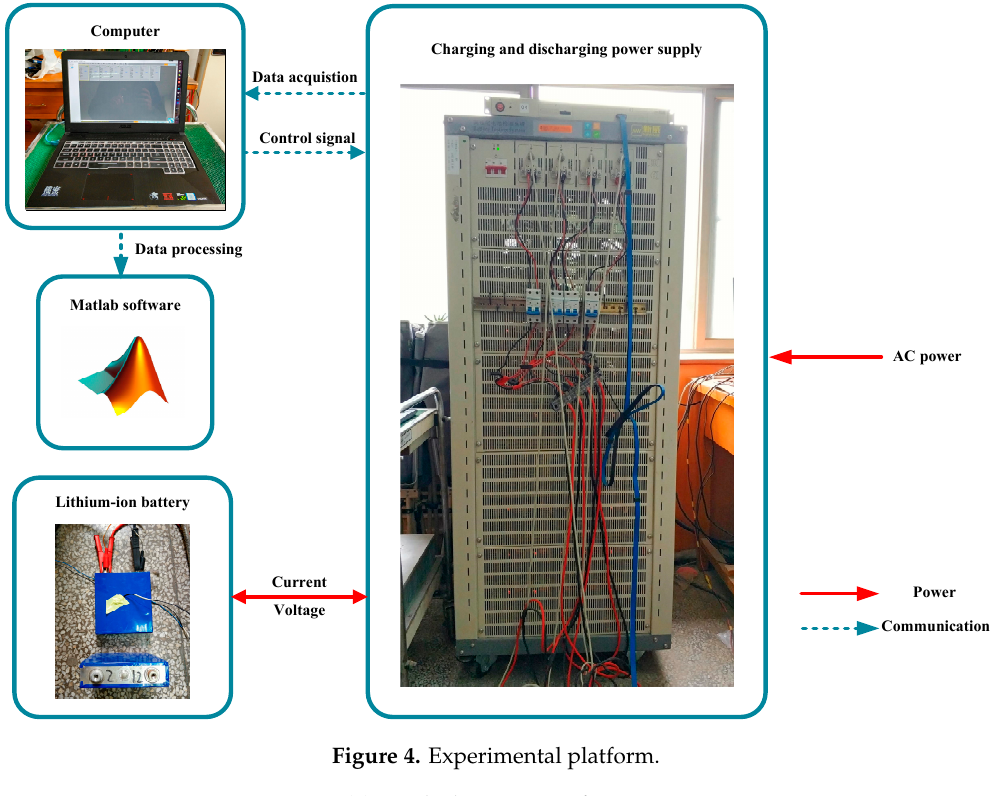
Table 1. The battery specifications.